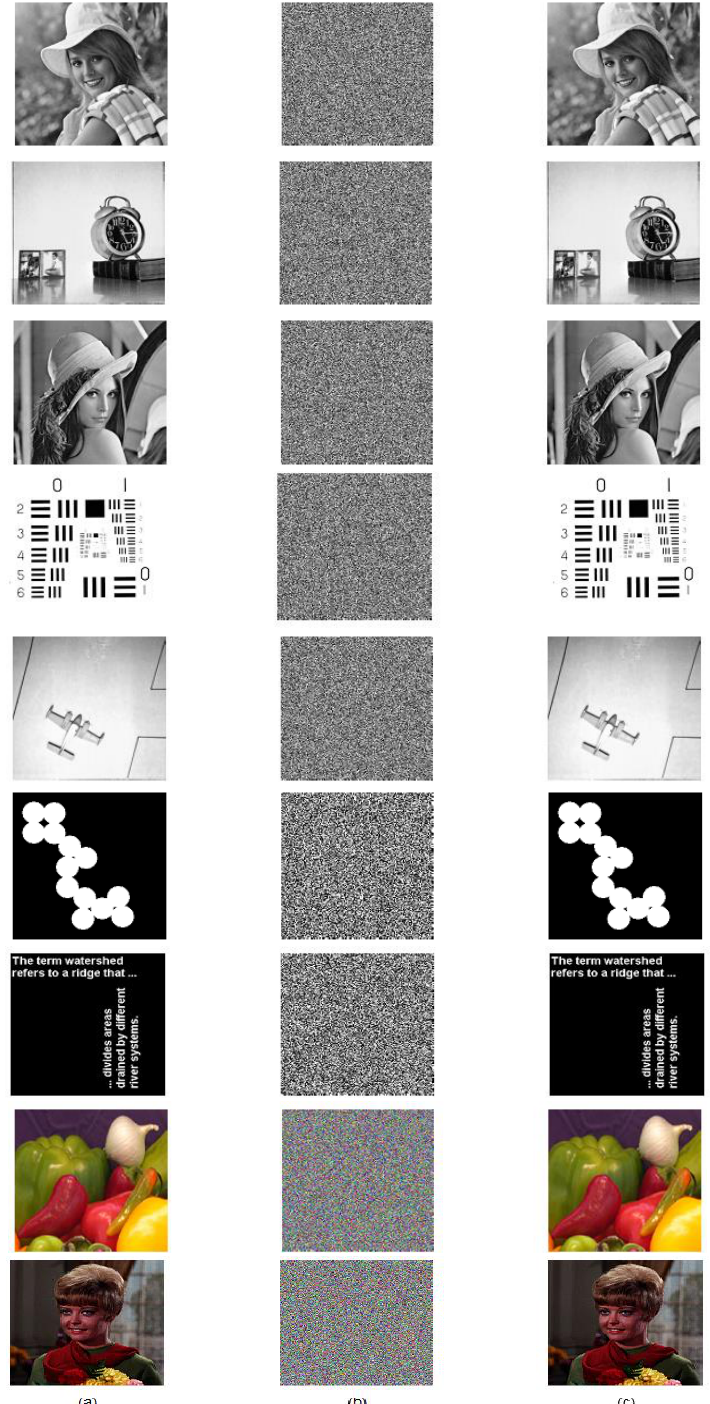
Figure 9. ( a ) Plain image; ( b ) Encrypted image; ( c ) Decrypted image.